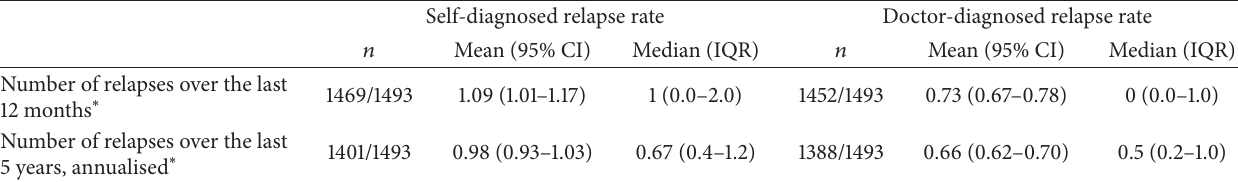
Table 6: Relapse rate for relapsing-remitting participants.